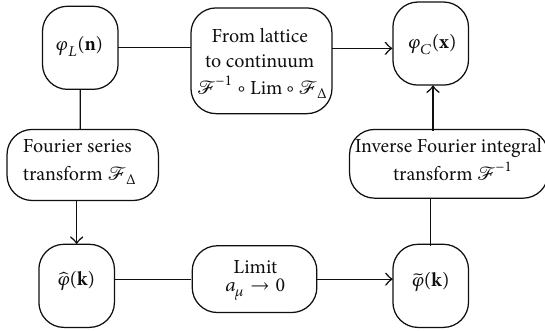
Figure 1: Diagram of sets of operations for scalar